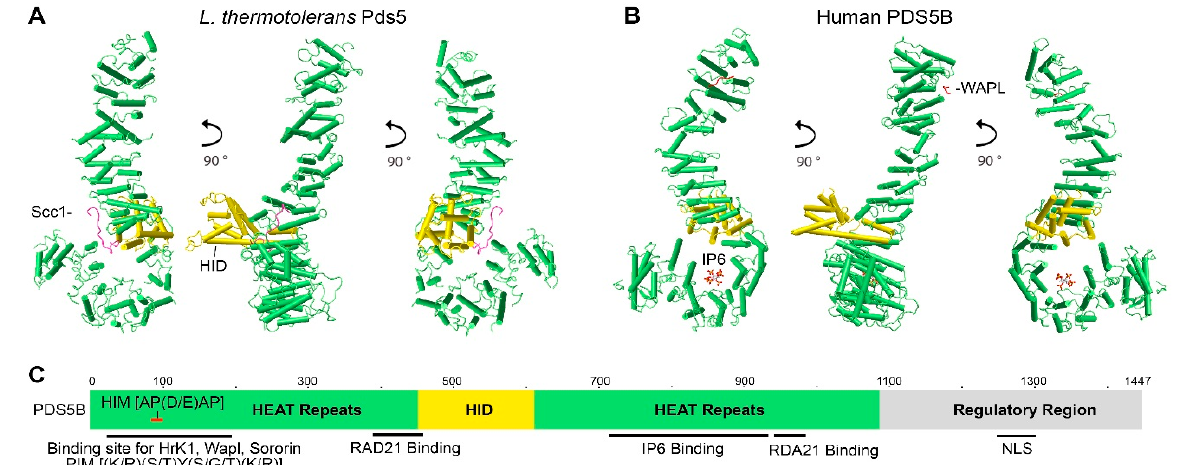
Figure 1. Structure and characteristics of the PDS5 protein. Crystal structure images of ( A ) L. thermotolerans Pds5 (PDB ID: 5F0O) and ( B ) human PDS5B (PDB ID: 5HDT) were generated by using NCBI’s web-based 3D structure viewer iCn3D. PDS5 is a hook-like molecule consisting of HEAT repeats (green sticks) with helical insert domain (HID, golden sticks) extruding on one side of the hook. Binding of Scc1/Rad21 (pink line) to L. thermotolerans Pds5 is shown in ( A ). Binding of WAPL (red line) to the C-terminus of human PDS5B and IP6 to the bottom of PDS5B hook-like structure are shown in ( B ). ( C ) Schematic drawing shows PDS5 molecular features. The relative site is based on human PDS5B. Hrk1 interacting motif (HIM) on PDS5 N-terminus interacts with the PDS5 interacting motif (PIM) on HrK1, WAPL, and sororin. RAD21 and IP6 interact with PDS5 in the middle region. Nuclear localization signal (NLS) is on the C-termini of PDS5A and PDS5B (Refer to Figure 2).